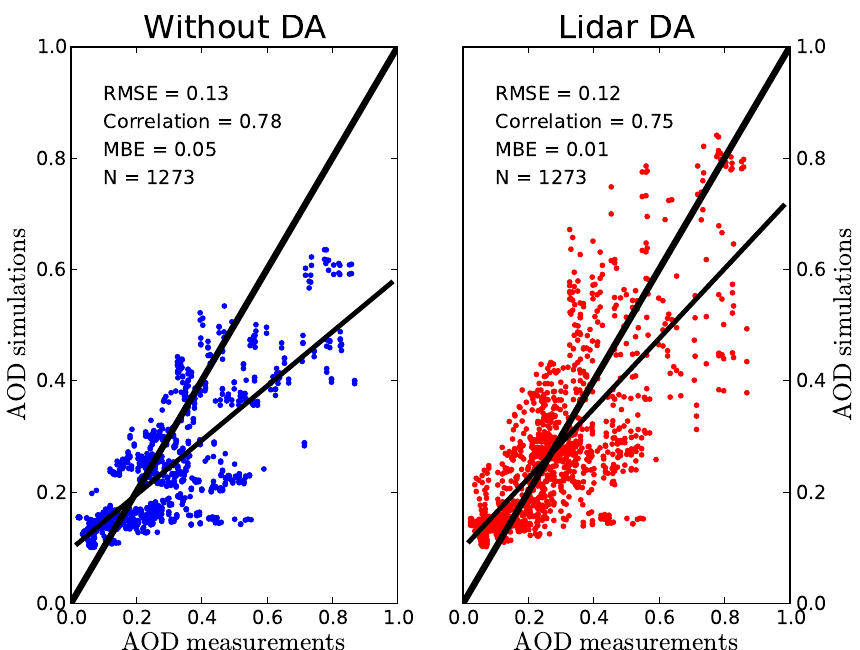
Figure 14. Scatter plots of simulated AODs without DA (left panel) and with DA (right panel) against AOD hourly measurements at different AERONET stations over the first 36 h of forecast.